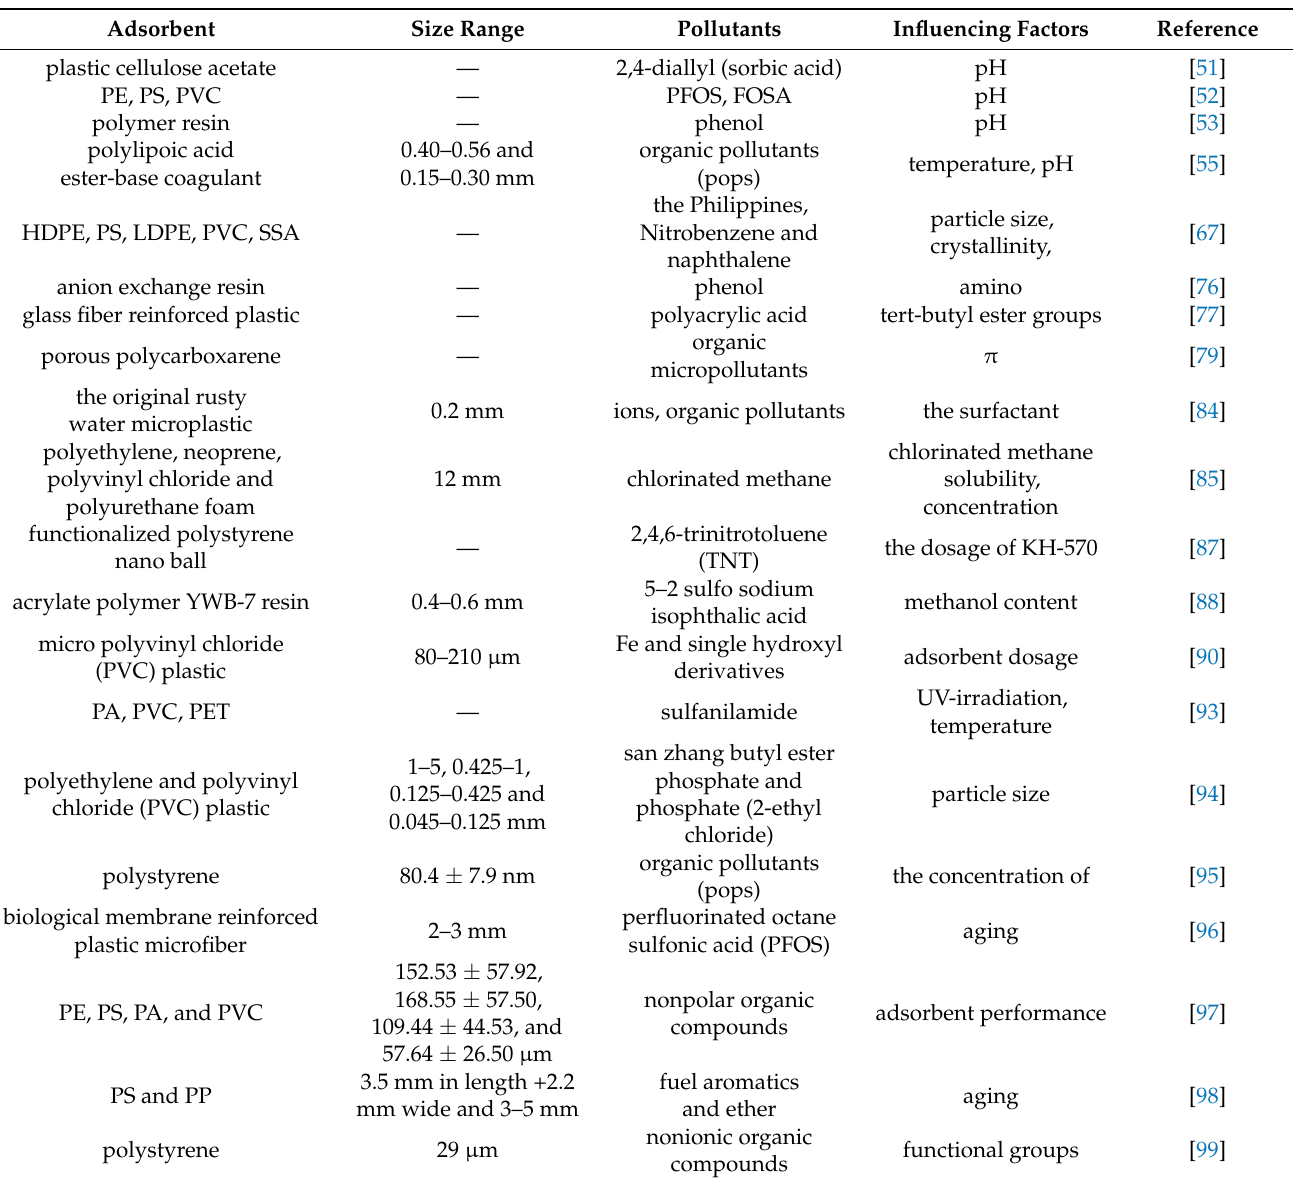
Table 1. Adsorption of organic